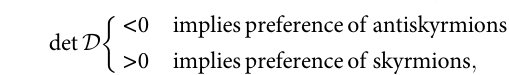
(cid:4) (cid:4) (cid:4) (cid:4) (cid:4) (cid:4) , with D ij ð Þ k being the k (cid:4) (cid:4) (cid:4) (cid:4) (cid:4) k